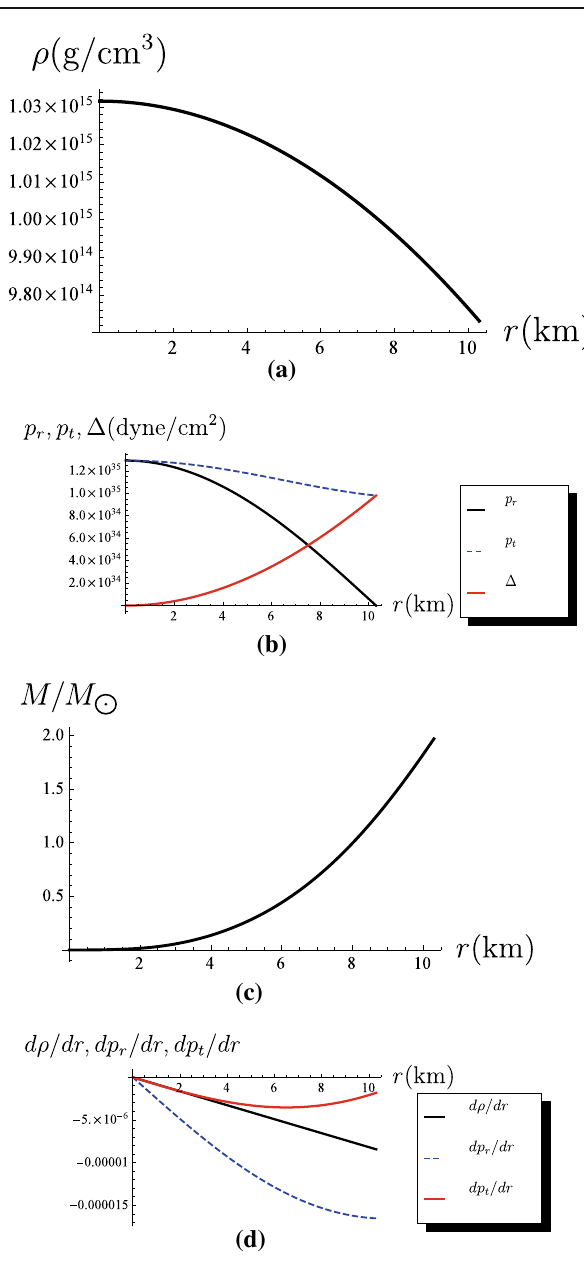
Fig. 1 Figures for PSRJ1614-2230